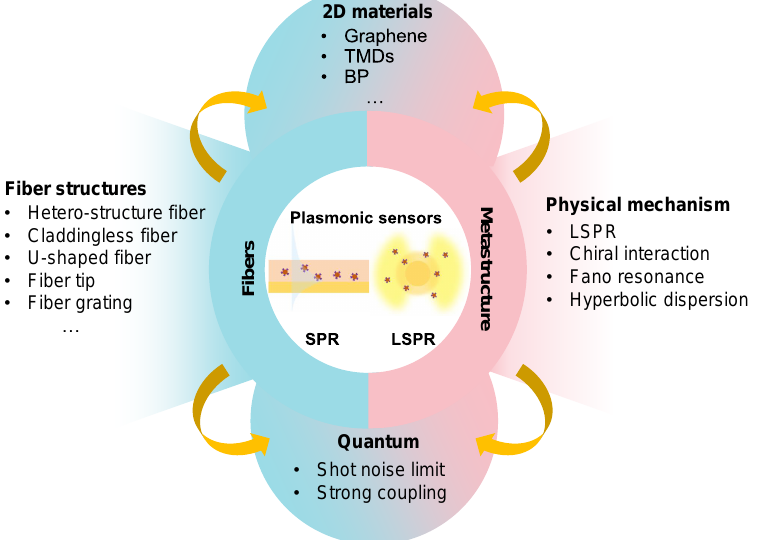
Figure 1. An overview of this review, the center is the sensing mechanism of plasmonic sensors. The light-matter interaction through the evanescent field of plasmonic structures is the common mechanism for analytes detection [30]. The detecting approaches used in SPR/LSPR sensors include analyzing the changes of wavelength [31], angular